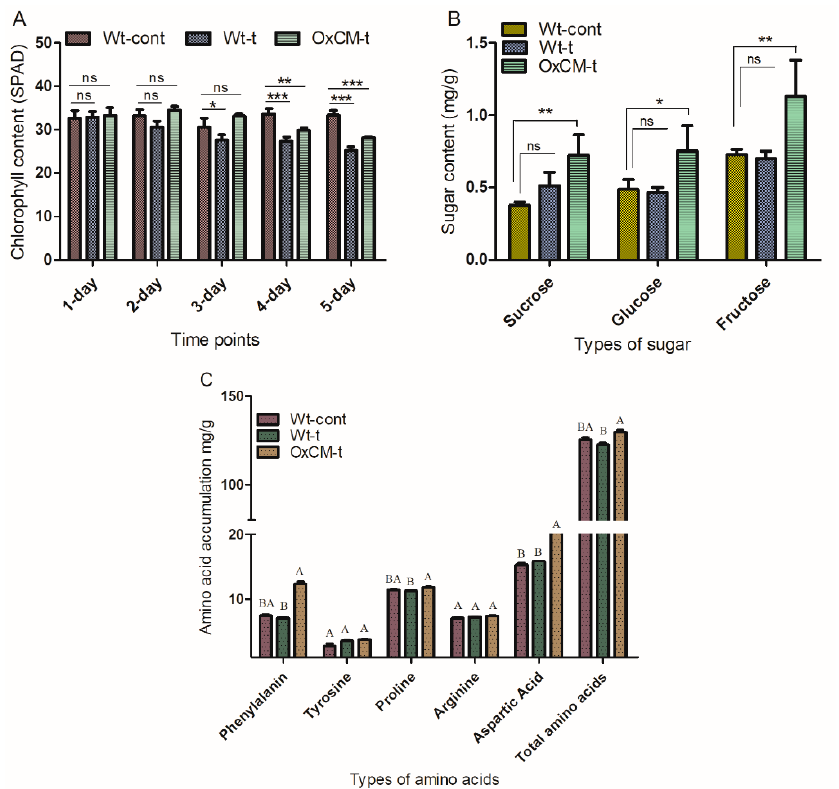
Figure 6. WBPH infection regulates chlorophyll, sugar and amino acid contents. ( A ) Inhibition of chlorophyll contents in Wt-cont, Wt-t and OxCM-t plants measured by SPAD. ( B ) Sucrose, glucose and fructose accumulation in Wt-cont, Wt-t and OxCM-t plants under WBPH infestation. ( C ) Various free amino acid and total amino acid quantification under WBPH infestation. Graph bars in ( A , B ) indicates mean ± standard deviation ( n = 3), ns indicates non significant and asterisks shows a significant difference (* p < 0.05, ** p < 0.01, *** p < 0.001) analyzed by two-way ANOVA, Bonferroni post hoc test. Different letters in ( C ) represents significant differences between means analyzed by Duncan’s multiple range test (DMRT). The experiments were repeated three times.